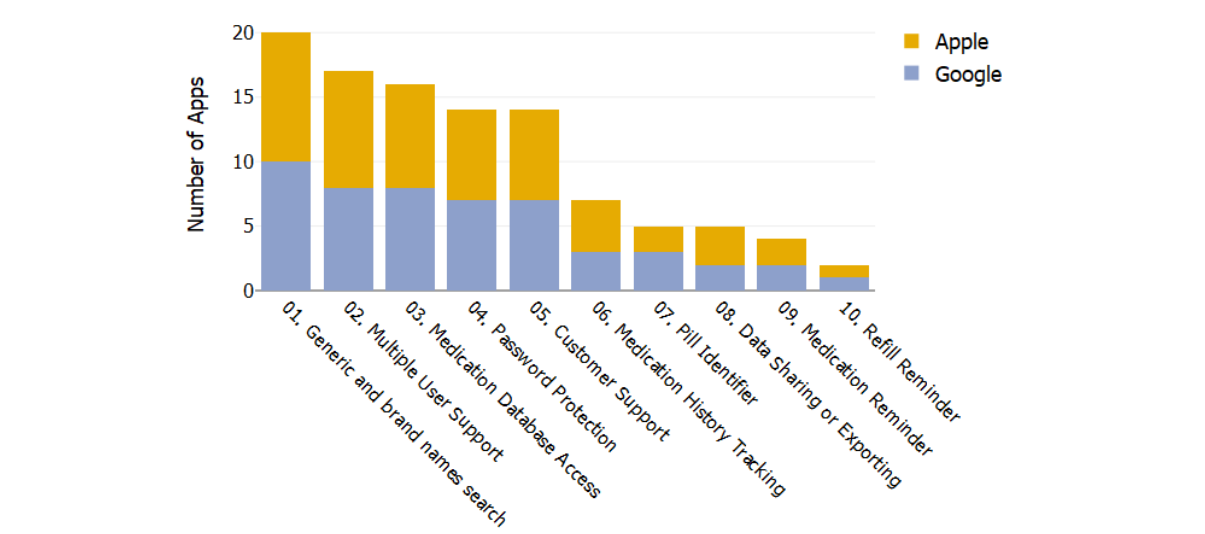
Figure 2. The number of apps that contain the secondary features listed on the x-axis.